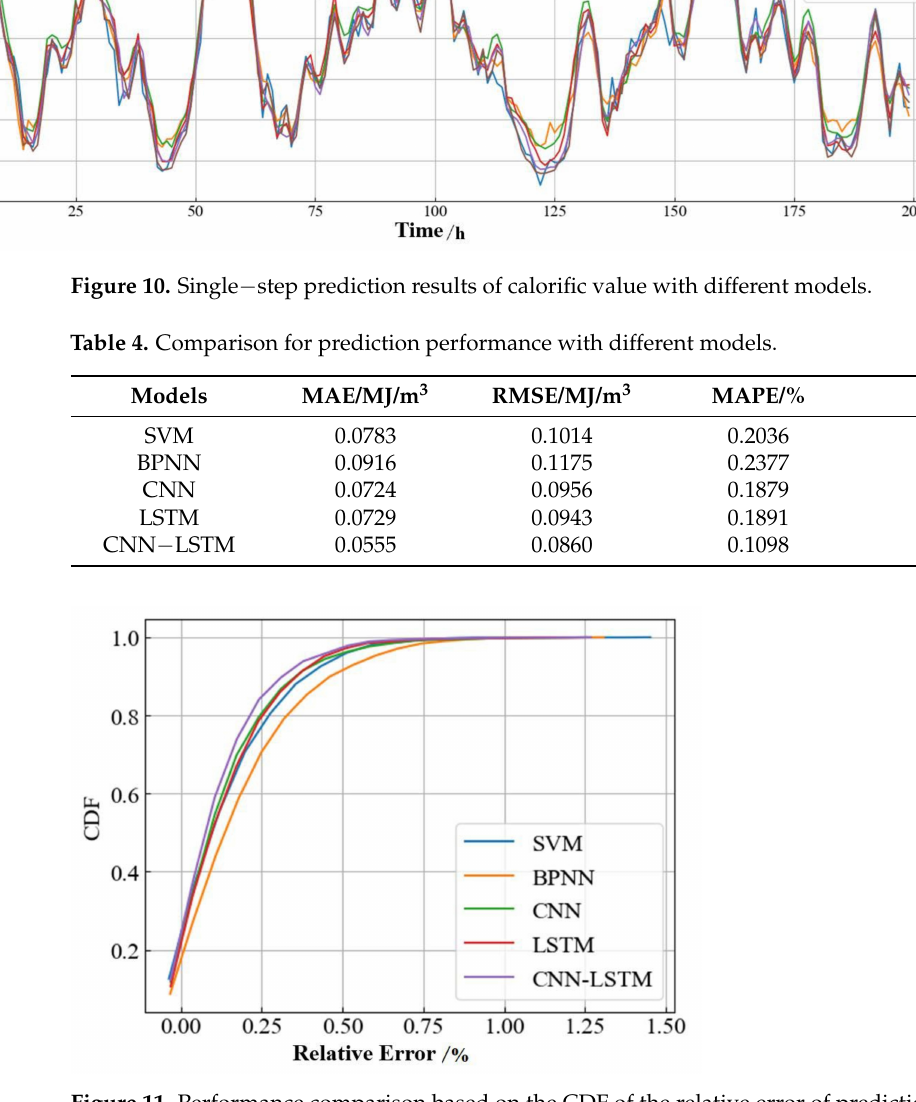
Figure 11. Performance comparison based on the CDF of the relative error of prediction